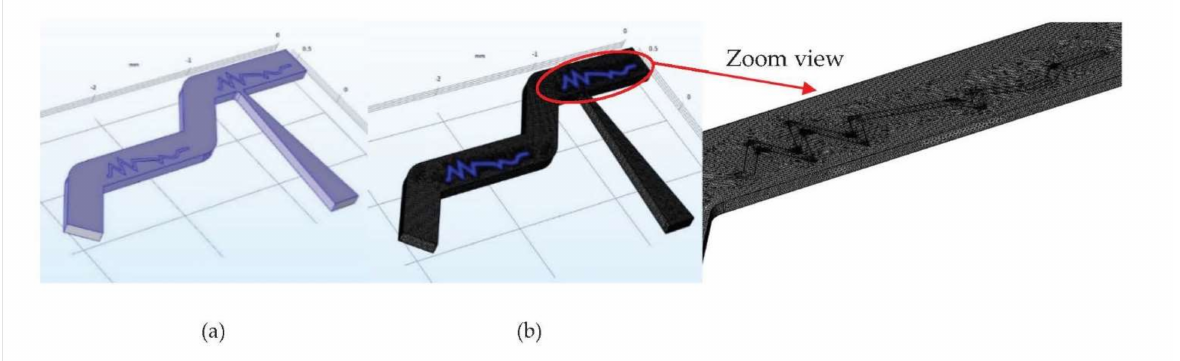
Figure 3. Corrugated dragonfly wing microchip: ( a ) Computational domain; ( b ) Computational domain